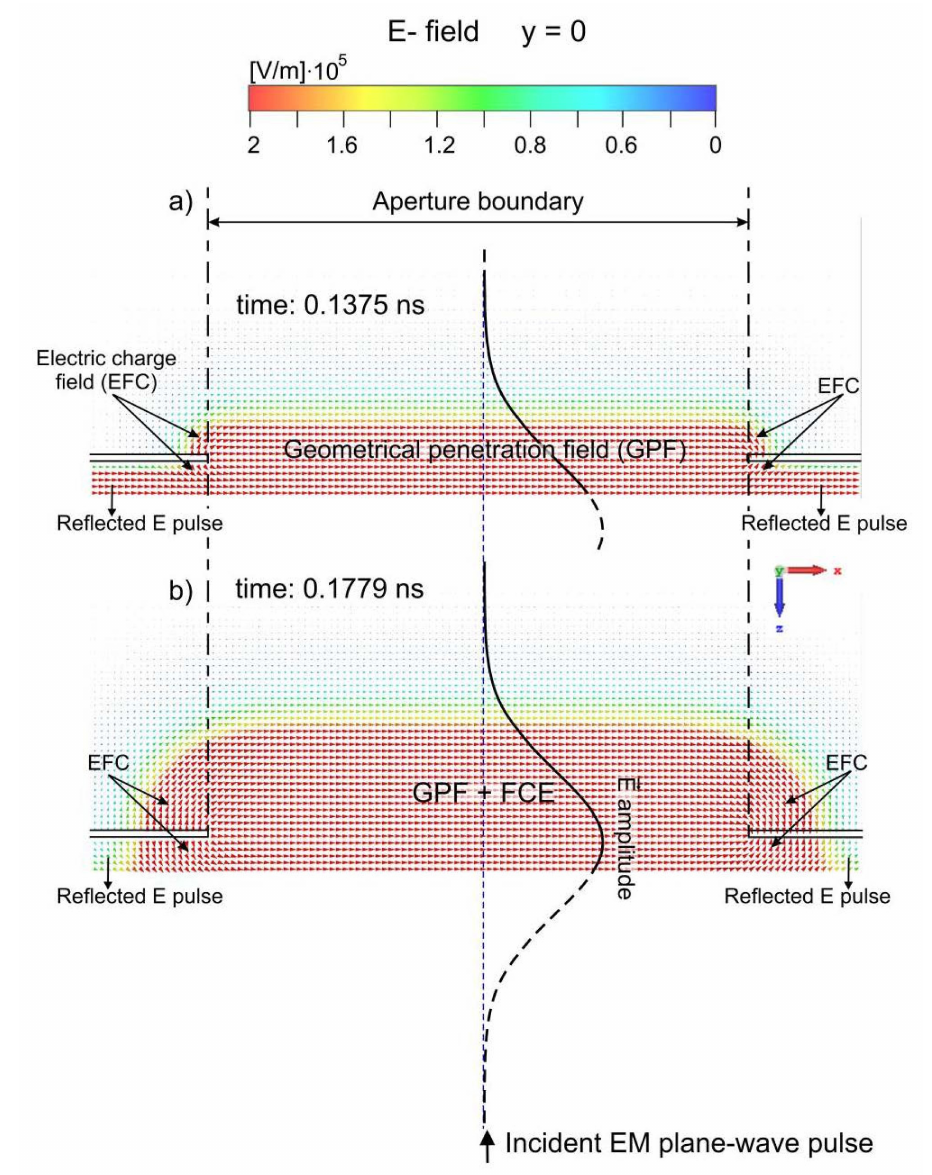
Figure 3. Illustration of the penetration and propagation of the electric field of the HPEM incident plane wave pulse in the enclosure at the early penetration stage for the area around the aperture: ( a ) t = 0.1375 ns, ( b ) t = 0.1779 ns in the plane y = 0 (the top view). GPF—the geometrical penetration field, ECF—the electric charge field. The color bar does not reflect the actual variation of the amplitude for larger amplitudes (relay on the field profile |